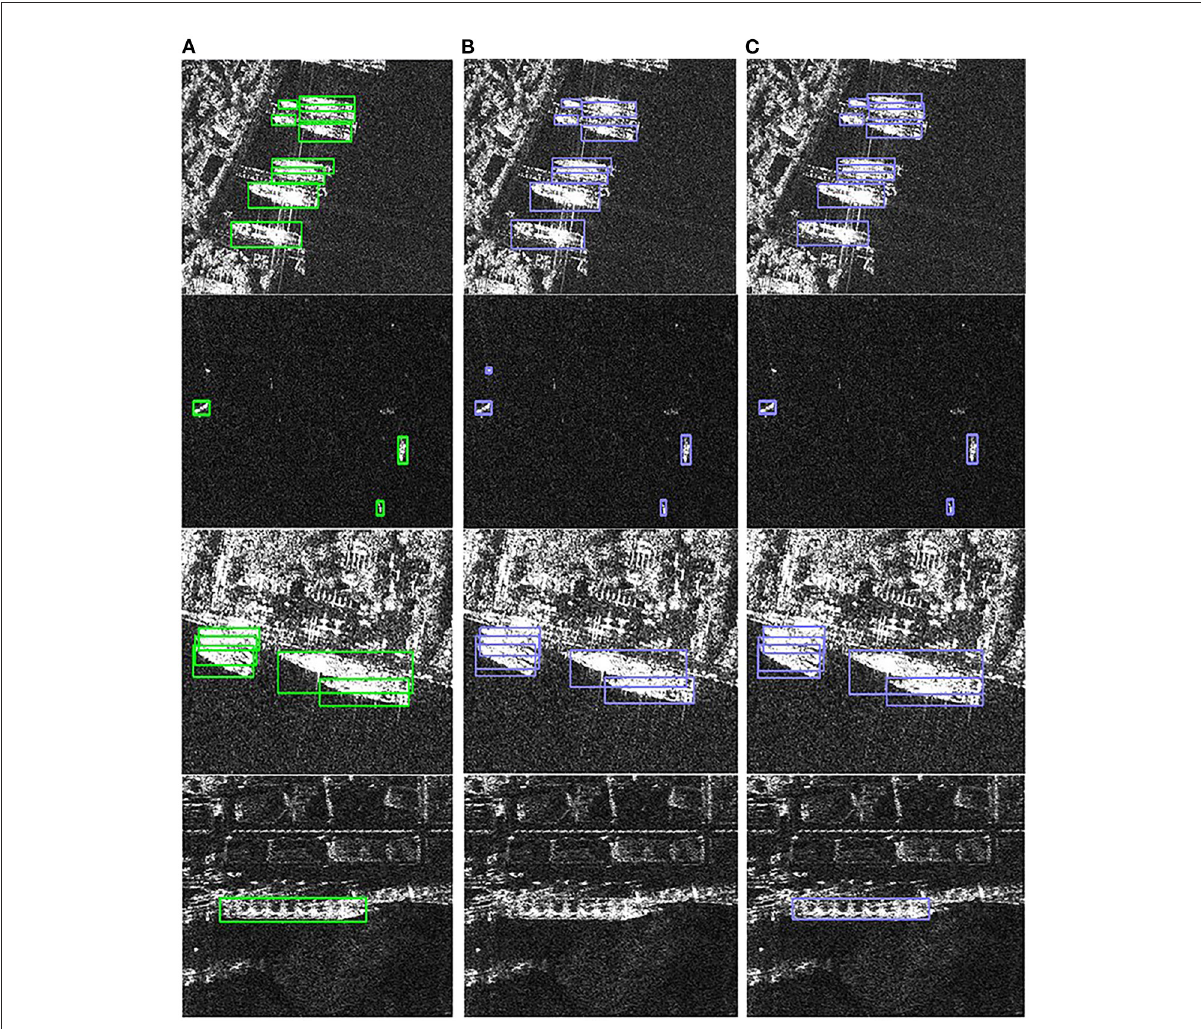
FIGURE5 Detection results of different proposed modules. (A) Ground truth. (B) Detection results without proposed modules. (C) Detection results with proposed